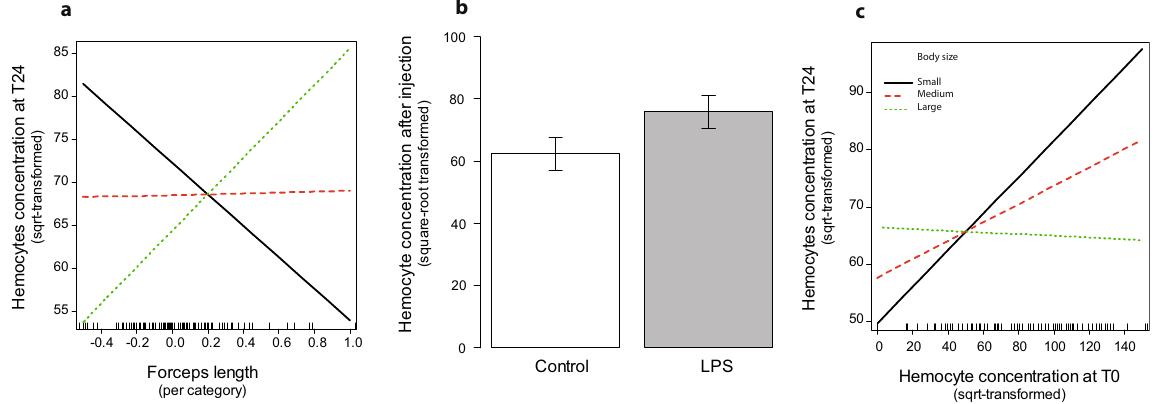
Figure 2. Effects of ( a ) the interaction between body size and the forceps length on hemocyte concentration 24 h after the immune challenge, ( b ) the type of immune challenge, and ( c ) the interaction between body size and basal hemocyte concentration. In the first and third panel, the straight lines represent males with small body size (1 st quartile of the distribution = 1.407), where the dashed lines represent the males with medium body size (median value = 1.437), and the dotted lines represent males with large body size (3 rd quartile of the distribution = 1.47). The dashes on the abscissa represent the distribution of males.